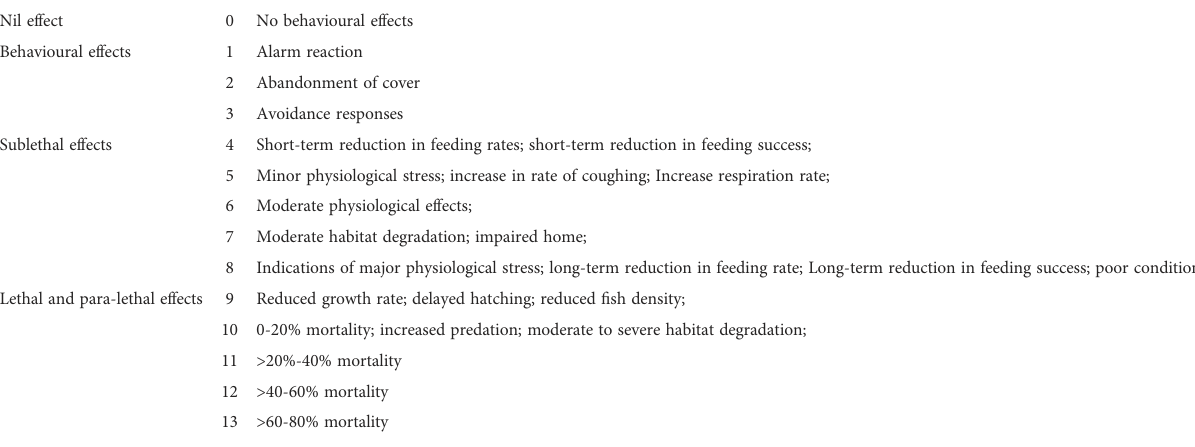
TABLE 2 Severity of ill effect on marine species (Newcombe and Jensen,